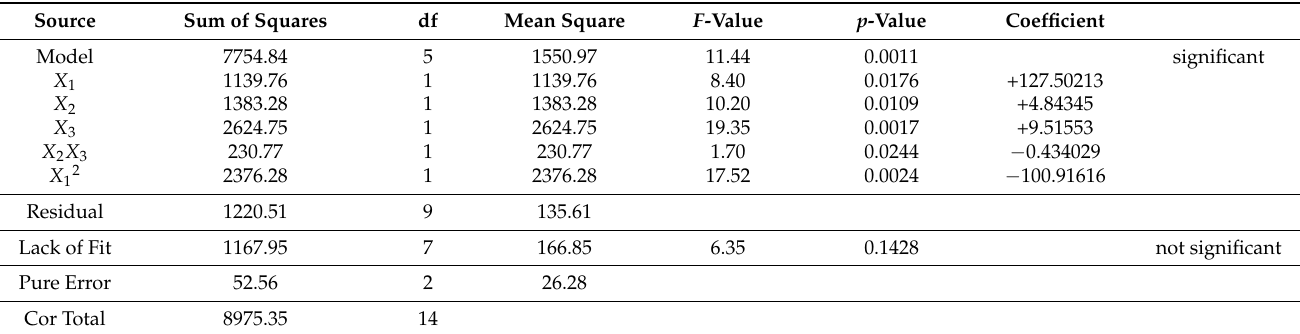
Table 3. ANOVA results for response: FRAP